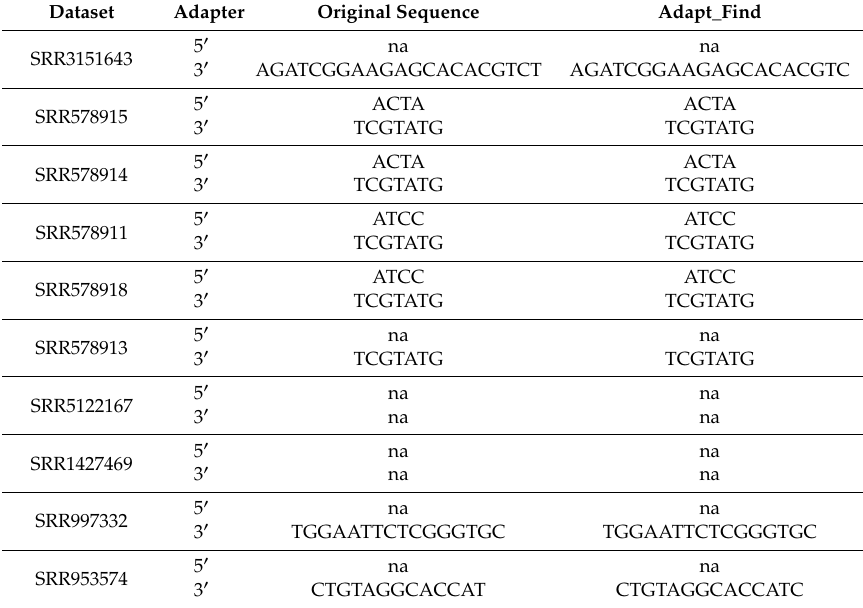
Adapter sequences in ten randomly chosen datasets predicted using Adapt_Find (default parameters used). “Original Sequence” is the adapter sequence obtained from the Methods section of the original study; “na”—no adapter applied in the dataset and / or no adapter identified by an